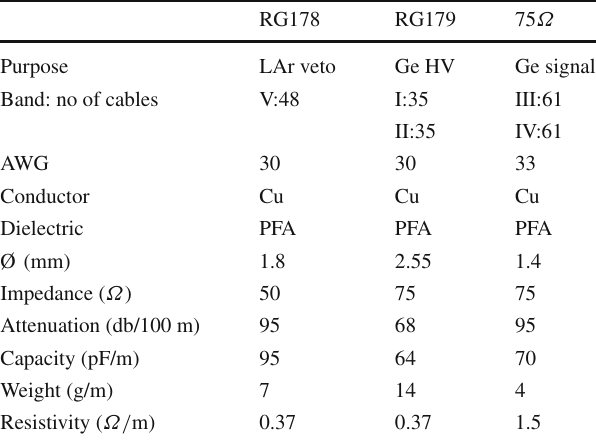
Table 3 List and characteristics of the coaxial cables in the 5 cable bands deployed in the Gerda Phase II cable